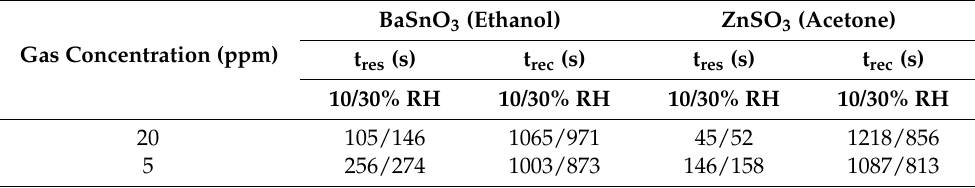
Table 3. Response (t res ) and recovery (t rec ) time of the BaSnO 3 and ZnSnO 3 sensors exposed to different gas concentrations of ethanol and acetone, respectively, in humid atmosphere, at operating temperature of 270 ◦ C. Results based on Figure 13.